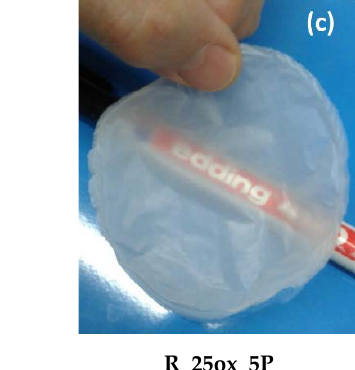
CMF., Figure S2: SEM images (scale of 10 µm), diameter and length distribution of CMF., Figure S3: TEM images (scale of 10 nm), diameter and length distribution of CNF., Figure S4: Variation in the according to the concentration of CNFs. specific viscosity, 𝜂𝜂 𝑠𝑠𝑠𝑠